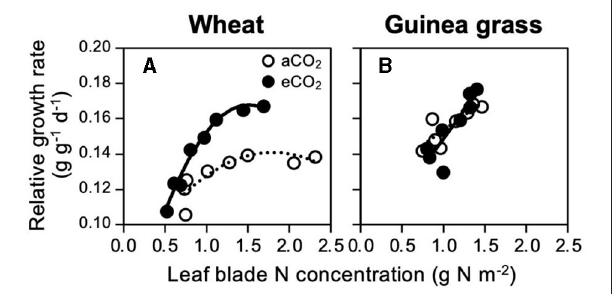
FIGURE 3 | Relationships between relative growth rate and foliar N concentration in C 3 wheat (A) and C 4 guinea grass (B) grown for 28 d in the chambers under ambient (aCO 2 ) or elevated (eCO 2 ) CO 2 treatments.